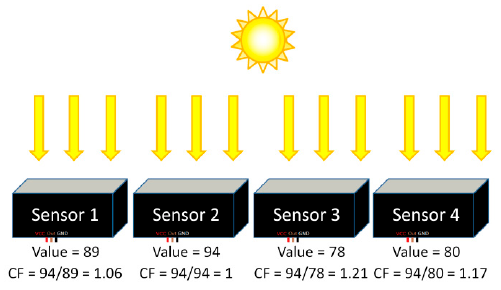
Figure 11. Example of sensor calibration where the Calibration Factor (CF) of each sensor is